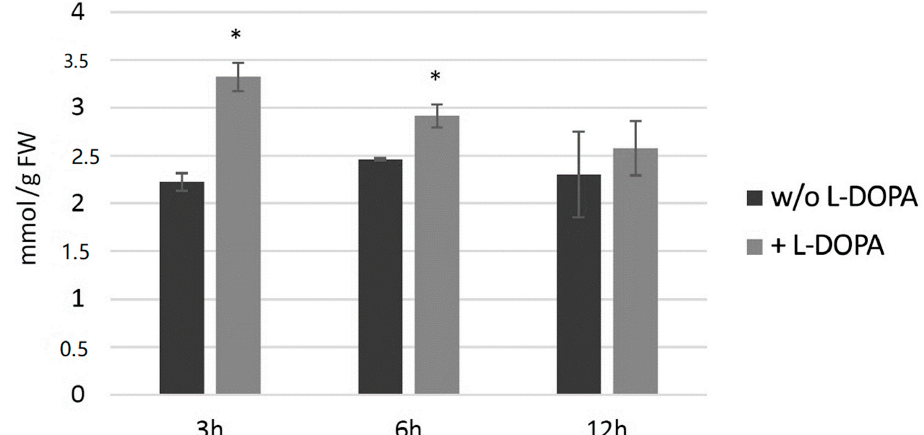
Figure 8. The level of H 2 O 2 in wild-type potato plants treated with 0.1 mg/mL L -DOPA (brighter bars) compared to the non-treated control (darker bars) presented as the means of six biological replicates ± standard deviation. Statistically significant changes ( p < 0.05) are marked with asterisks. Antioxidants 2020 , 9 , x FOR PEER REVIEW